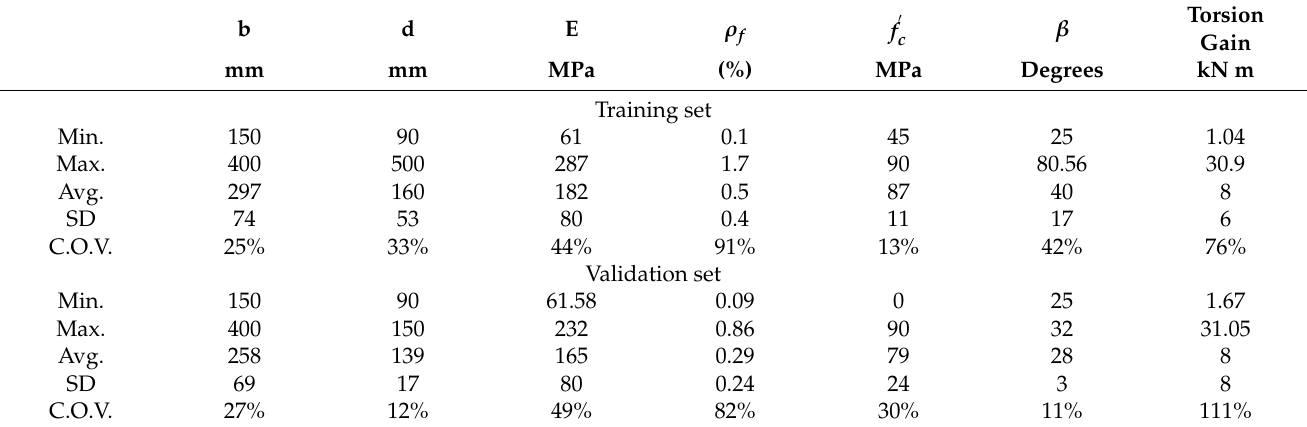
Table 4. Statistical analysis of training and validating